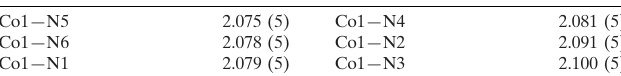
Selected bond lengths (A˚ ).